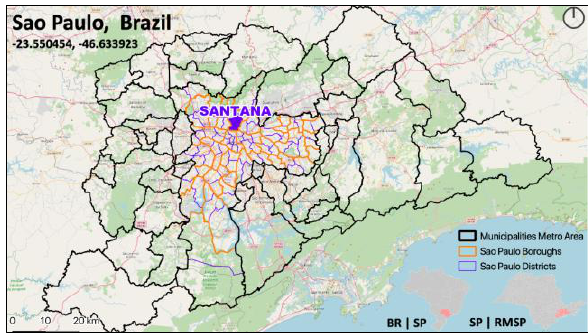
Figure 1. Overview of the study area and its location in São Paulo, Brazil.